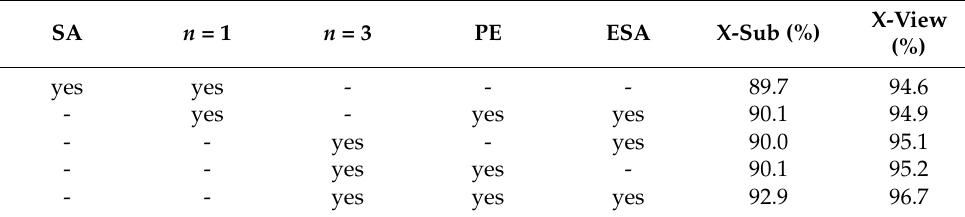
Table 1. Using the NTU RGB+D dataset, the SSAN ablation research was conducted.